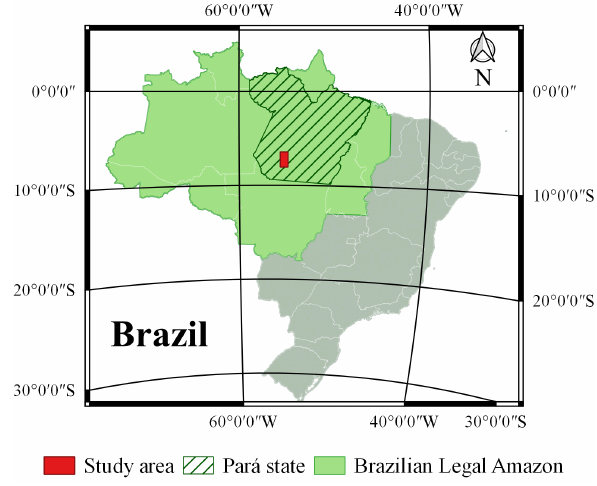
Figure 2. Geographical localization of the study